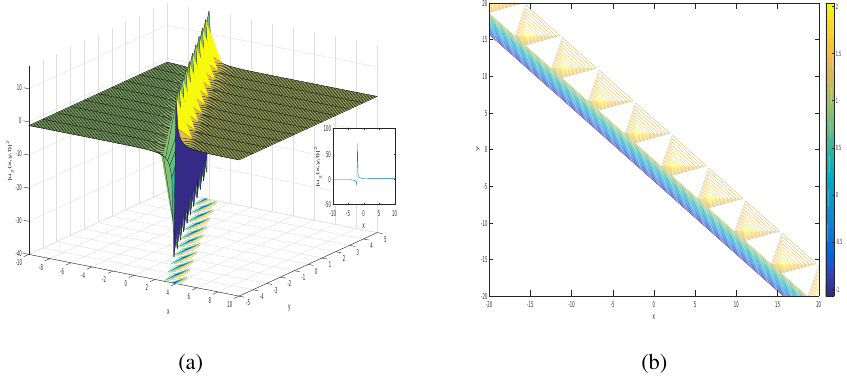
Figure 3 The (a) 3D, 2D surfaces (b) contour plot of Eq.